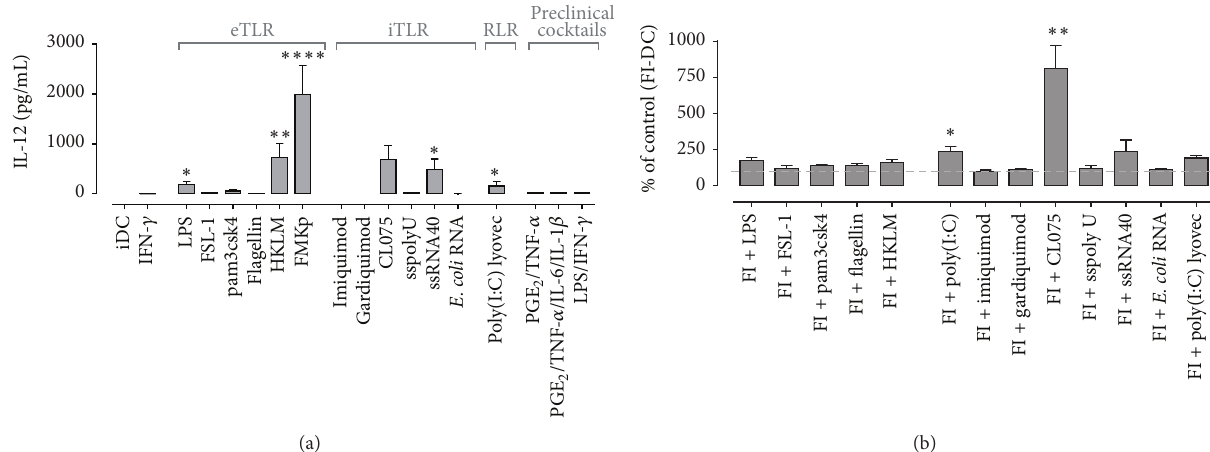
Figure 2: DC-derived IL-12p70 production upon single and multiple PRR triggering. (a) iDC were matured in the presence of IFN- 𝛾 and different PRR triggers as indicated on 𝑥 -axis. Cytokine production was determined in the culture supernatant after 48 h of maturation. Data are represented as mean + SEM and representative of at least 6 independent experiments. Kruskal-Wallis test significance as compared to DC matured with IFN- 𝛾 . ∗ 𝑃 ≤ 0.05 , ∗∗ 𝑃 ≤ 0.01 , and ∗∗∗∗ 𝑃 ≤ 0.0001 . (b) Synergy of FMKp/IFN- 𝛾 (FI) maturation with poly(I:C) and CL075 as measured by their IL-12p70